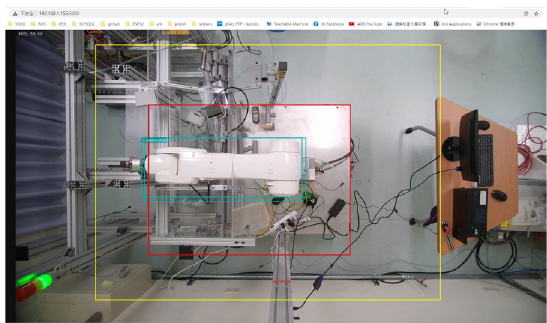
Figure 17. System shows safe when no object detected.